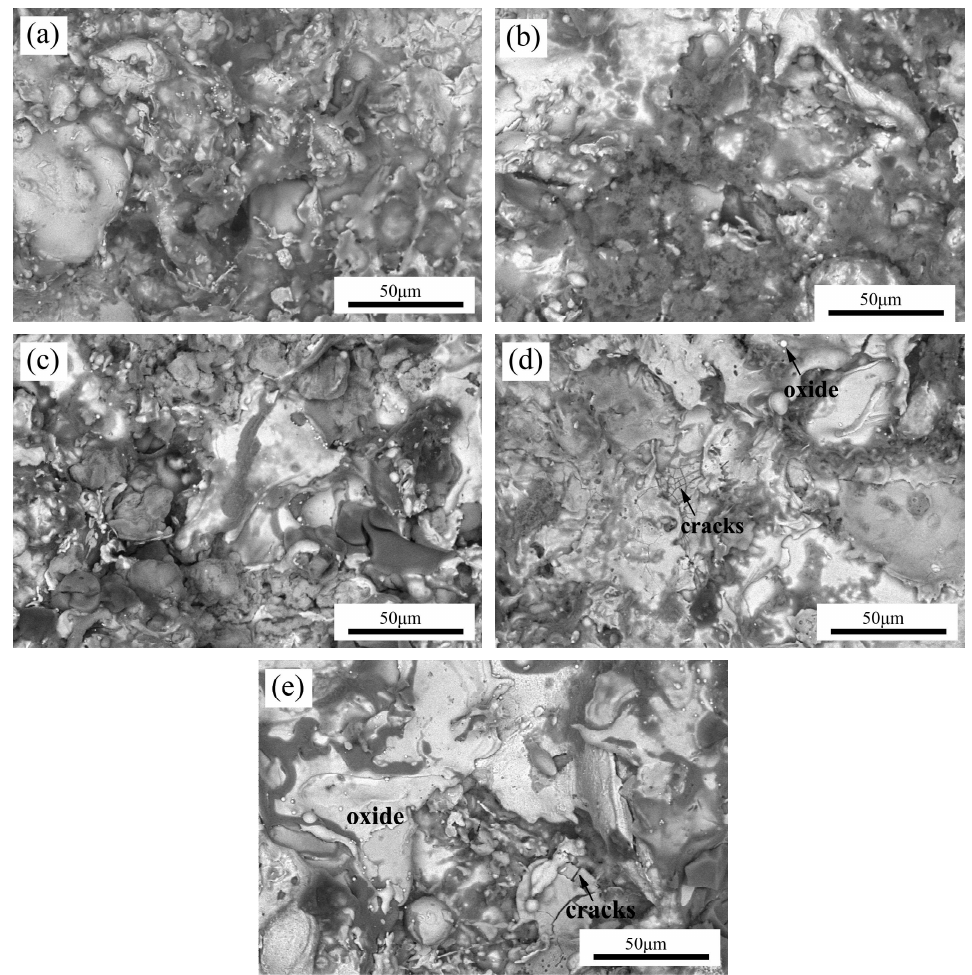
Figure 8. Surface morphologies of the coatings after corrosion ( a ) #A, ( b ) #B, ( c ) #C, ( d ) #D, and ( e ) FeCrAl .